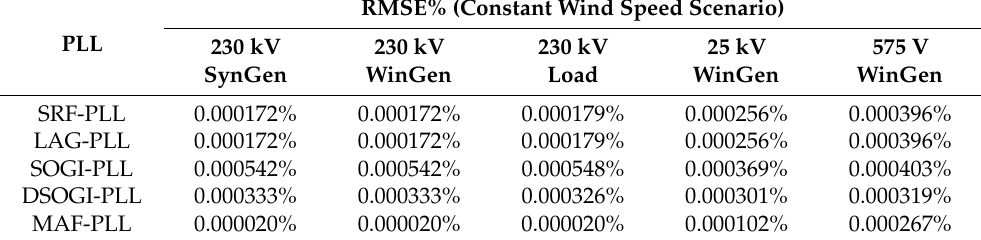
Table 3. Relative RMSE values for the PLLs located at the different buses in the constant wind speed scenario.